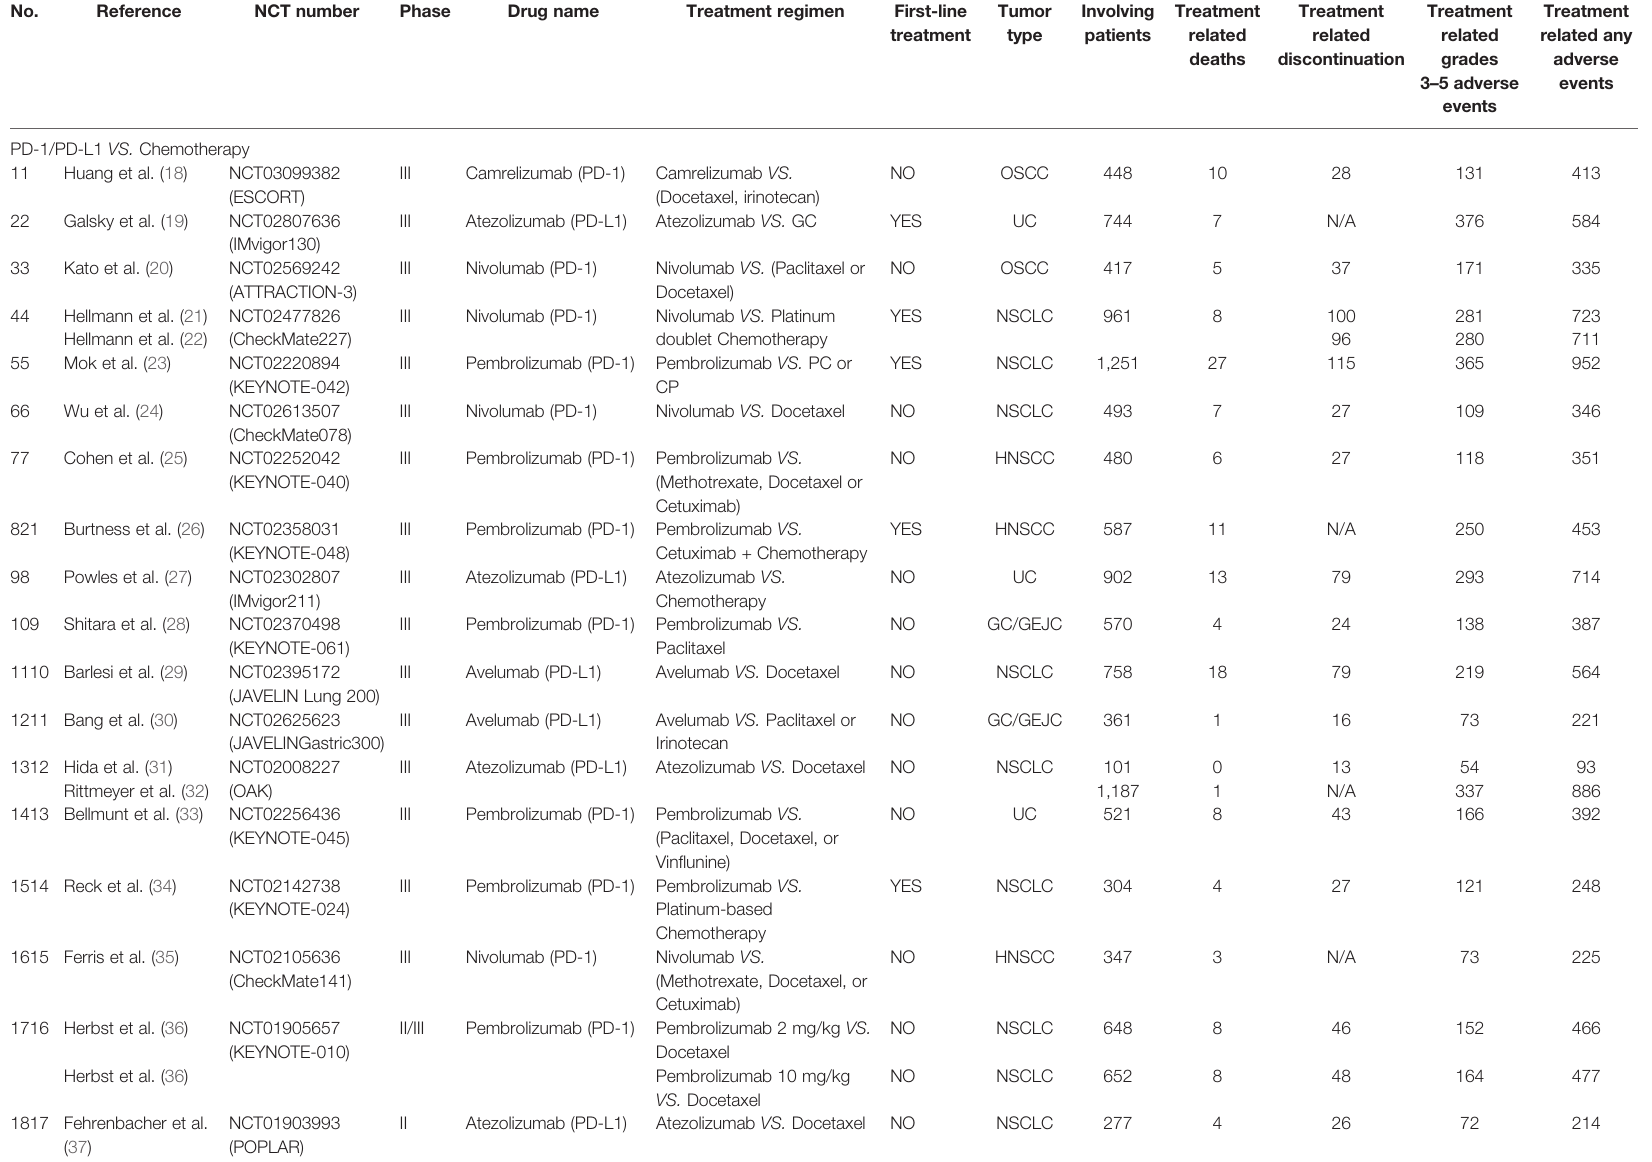
TABLE 1 | Baseline characteristics of included